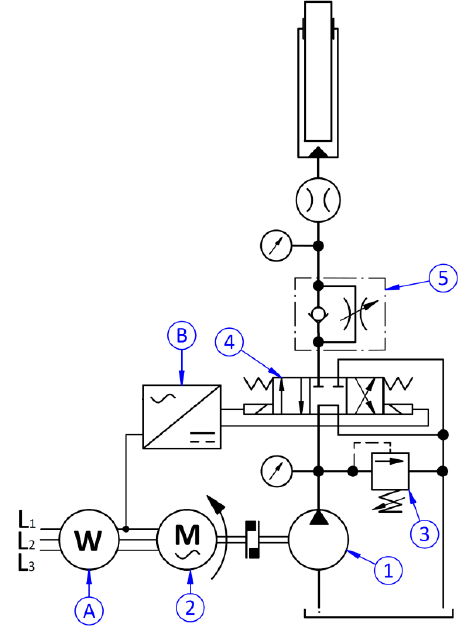
Figure 1. Hydraulic scheme of conventional scissor lift.